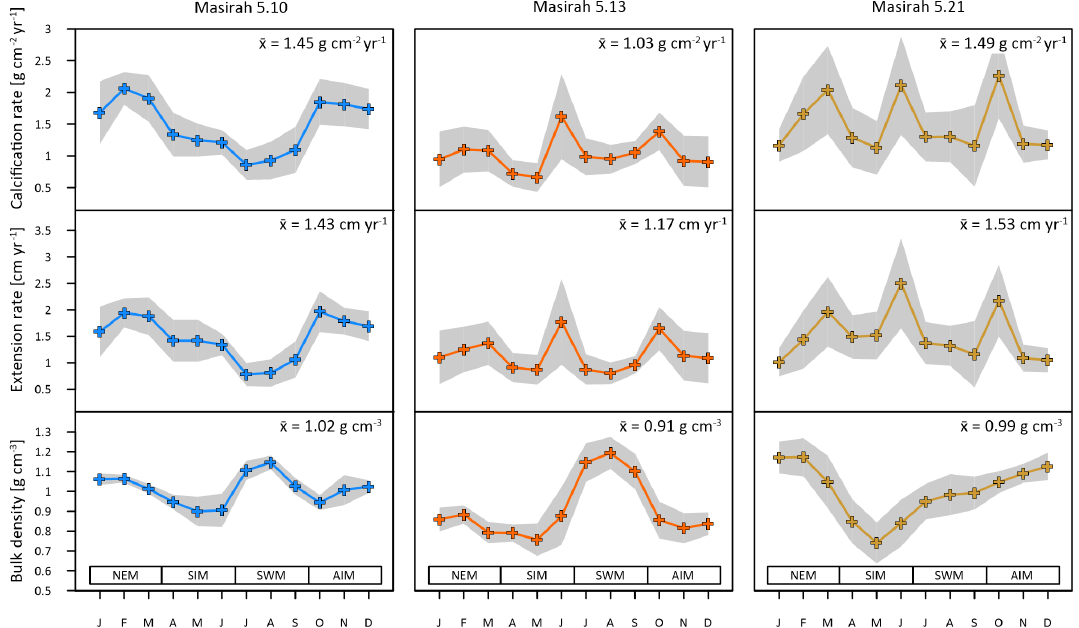
Figure 5. Results of multi-year monthly means of calcification rate, extension rate and skeletal density of three corals from Masirah Island (blue, orange, yellow). The grey shaded area represents uncertainty (1 σ ) between equal months of consecutive years. Seasonal abbreviations: NEM (northeast monsoon), SIM (spring intermonsoon), SWM (southwest monsoon), AIM (autumn intermonsoon). Table 2. Mean annual skeletal bulk density, linear extension rate and calcification rate ( ± 1 σ ) of all six coral specimens from Masirah Island. Uncertainty (1 σ ) represents variability between consecutive record